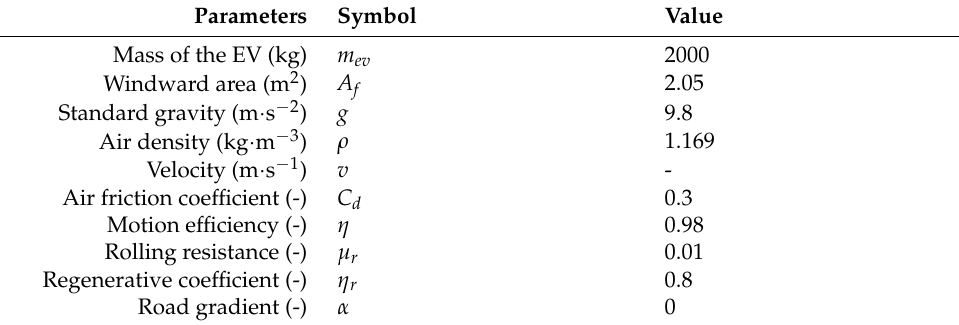
Table 6. Parameters of vehicle specification and driving